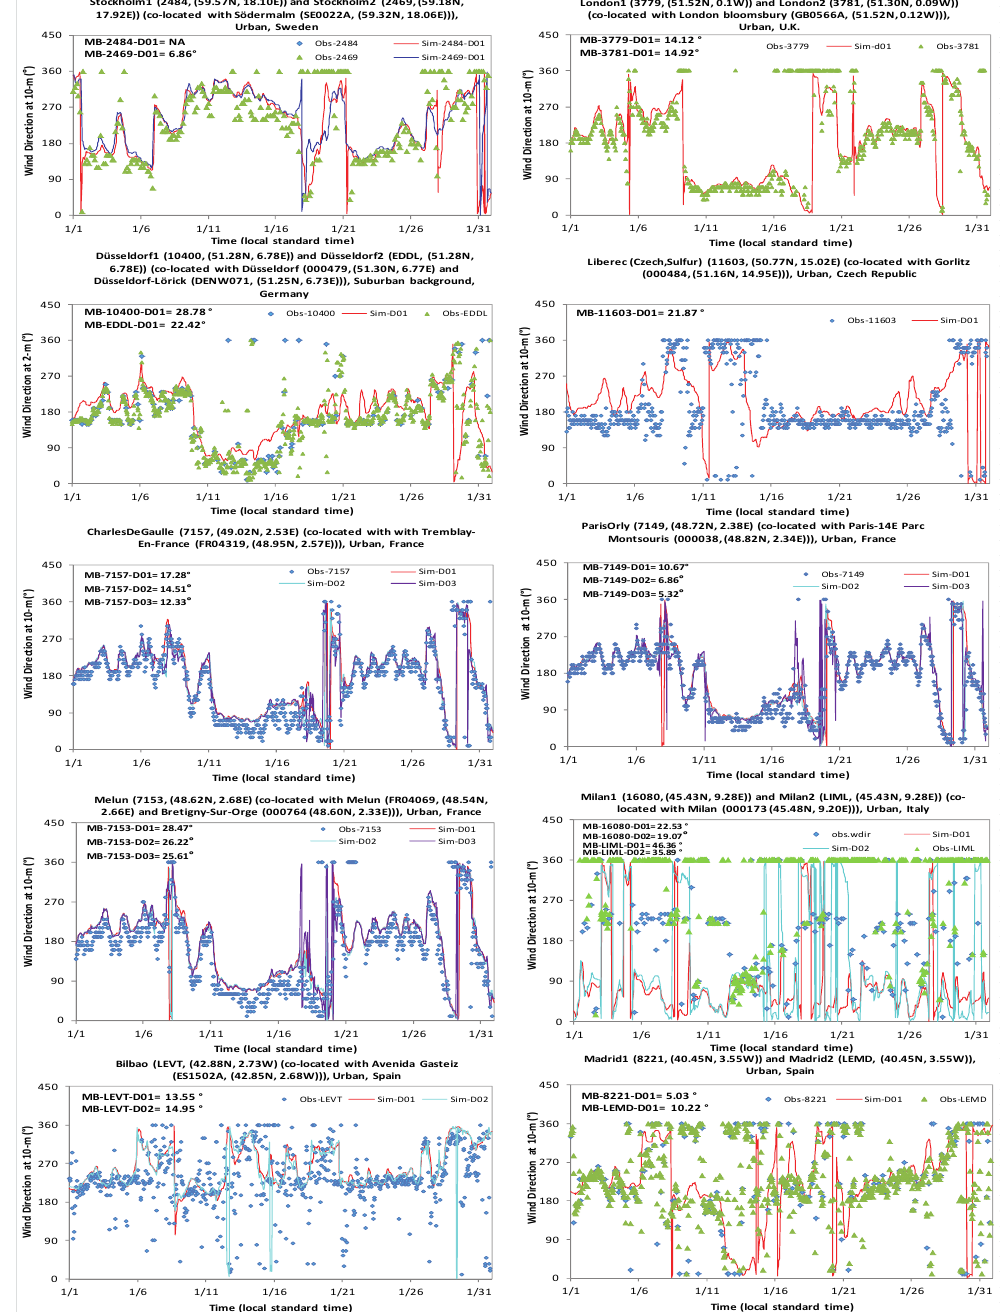
Figure 14. Simulated and observed 10-m wind direction in January 2001 at selected sites. Statistics is not available (NA) at one site (Stockholm 1) where observations were not available.